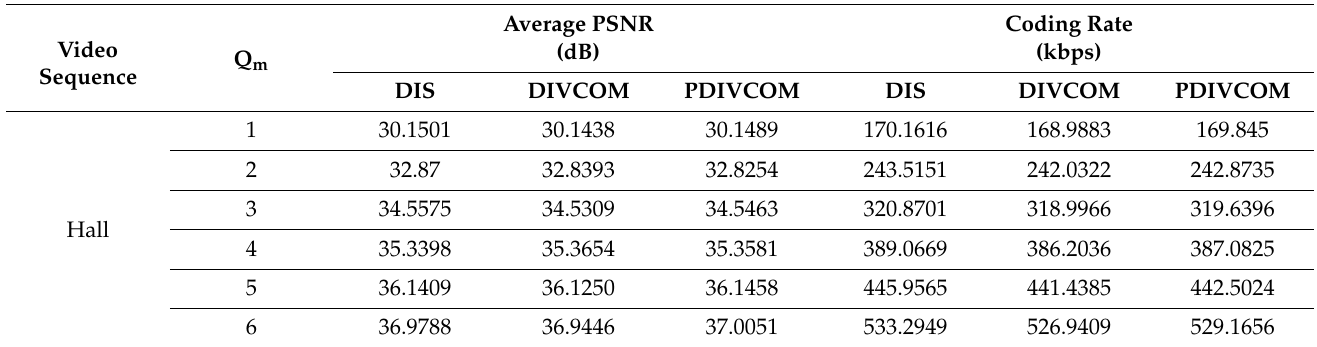
Table 8. Visual quality and rate performance evaluation of different codecs for “Hall” video sequence for frame rate 15 Hz.